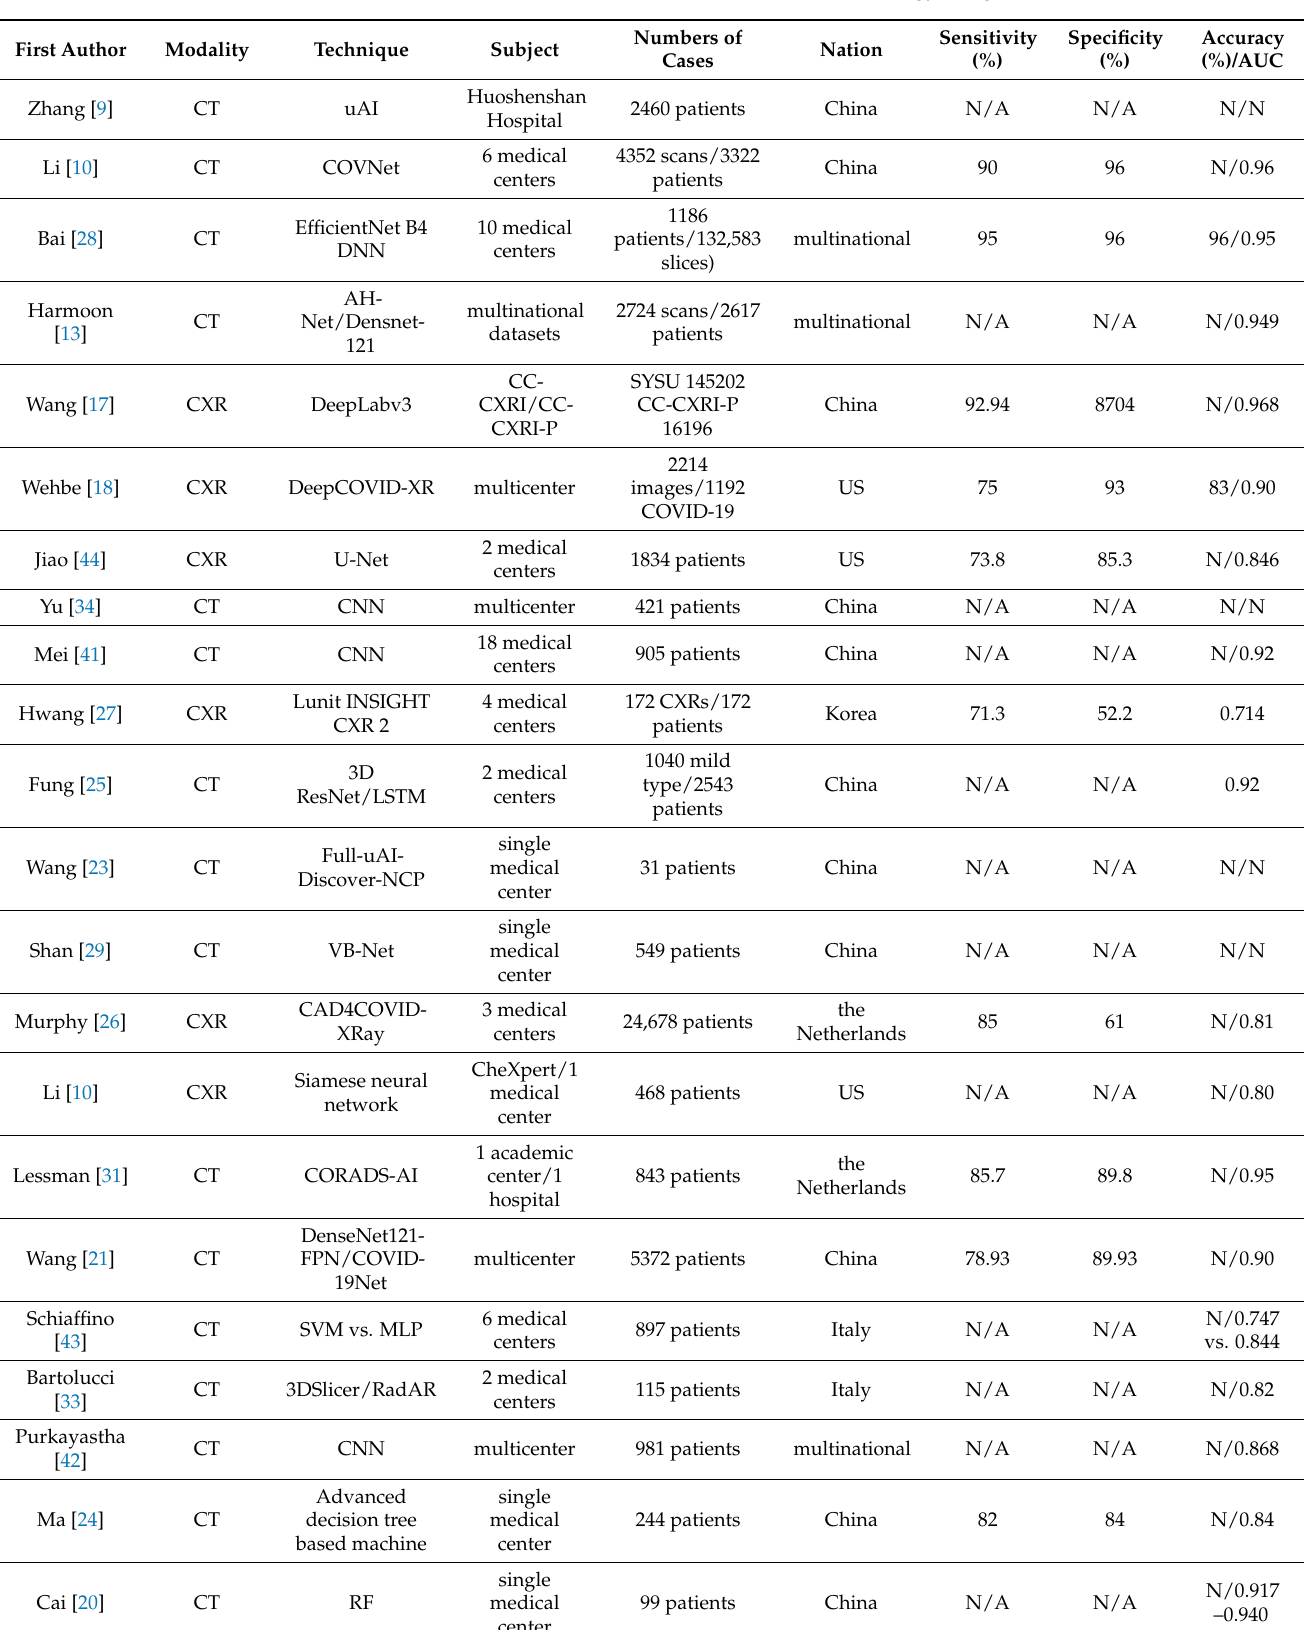
Table 1. Partial DL and AI research based on COVID-19 radiology